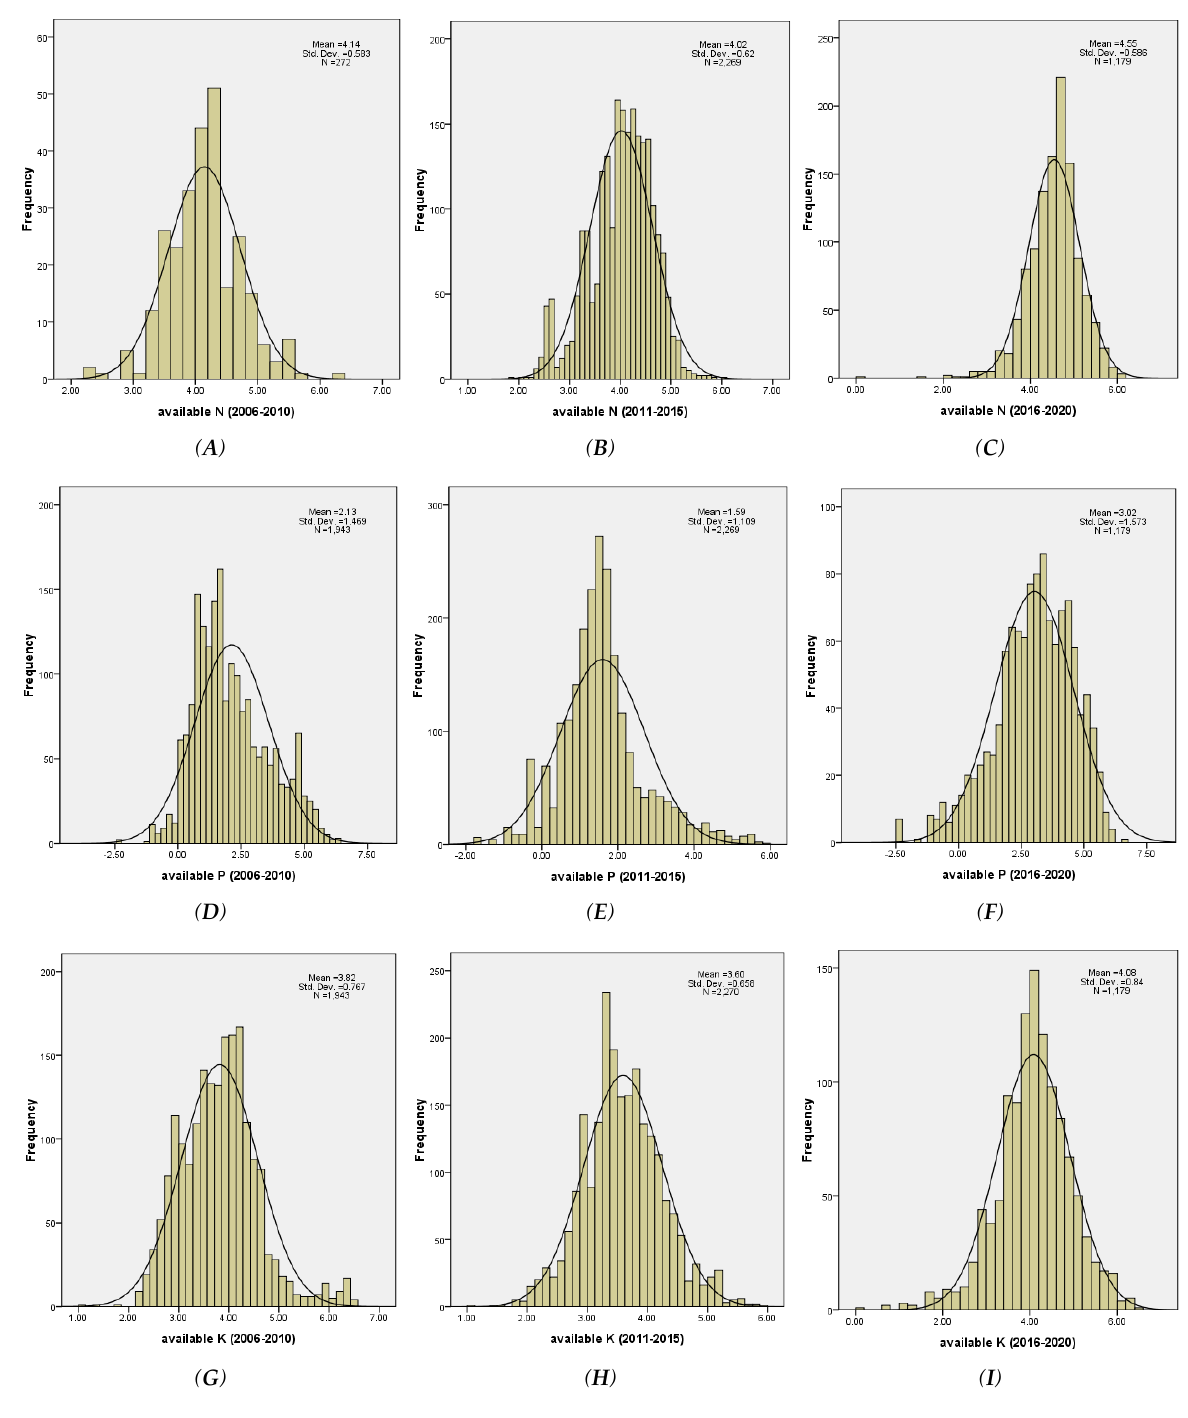
Figure 3. The density histogram of available nitrogen ( A ) for the 2006–2010 time period. The density histogram of available nitrogen ( B ) for the 2011–2015 time period. The density histogram of available nitrogen ( C ) for the 2016–2020 time period. The density histogram of available phosphorus ( D ) for the 2006–2010 time period. The density histogram of available phosphorus ( E ) for the 2011–2015 time period. The density histogram of available phosphorus ( F ) for the 2016–2020 time period. The density histogram of available potassium ( G ) for the 2006–2010 time period. The density histogram of available potassium ( H ) for the 2011–2015 time period. The density histogram of available potassium ( I ) for the 2016–2020 time